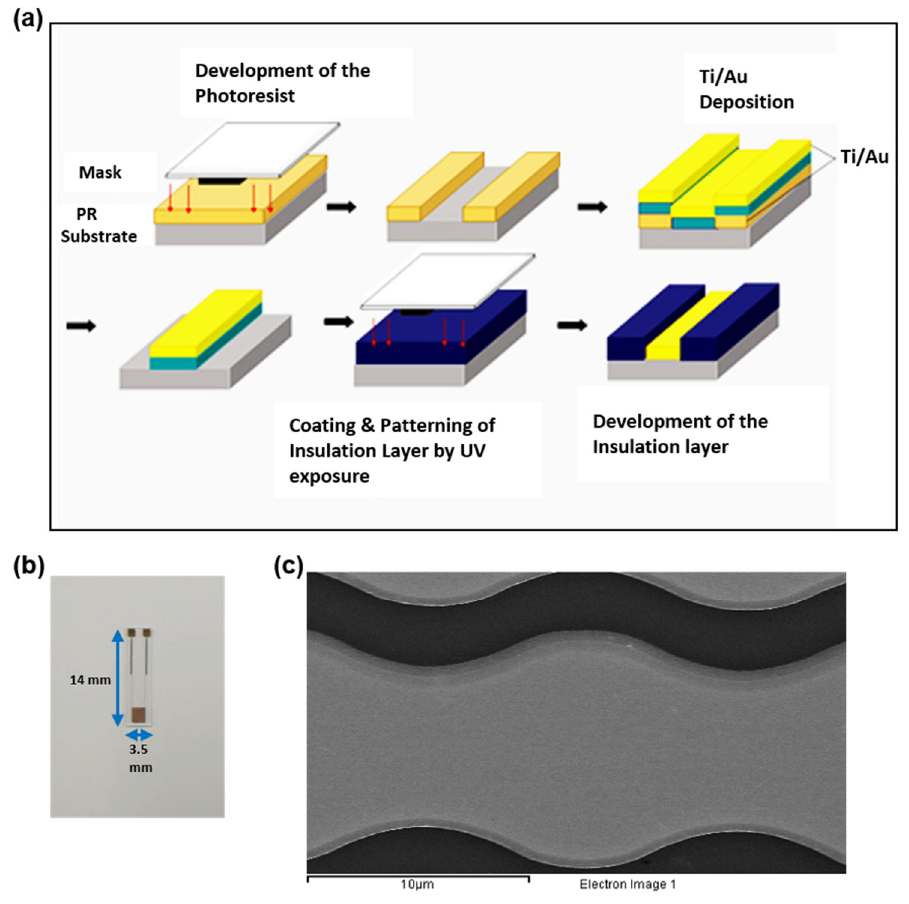
Figure 1. ( a ) Fabrication of ICE, ( b ) Photograph of ICE, and ( c ) Scanning electron microscope image of chain-shaped gold finger of ICE.